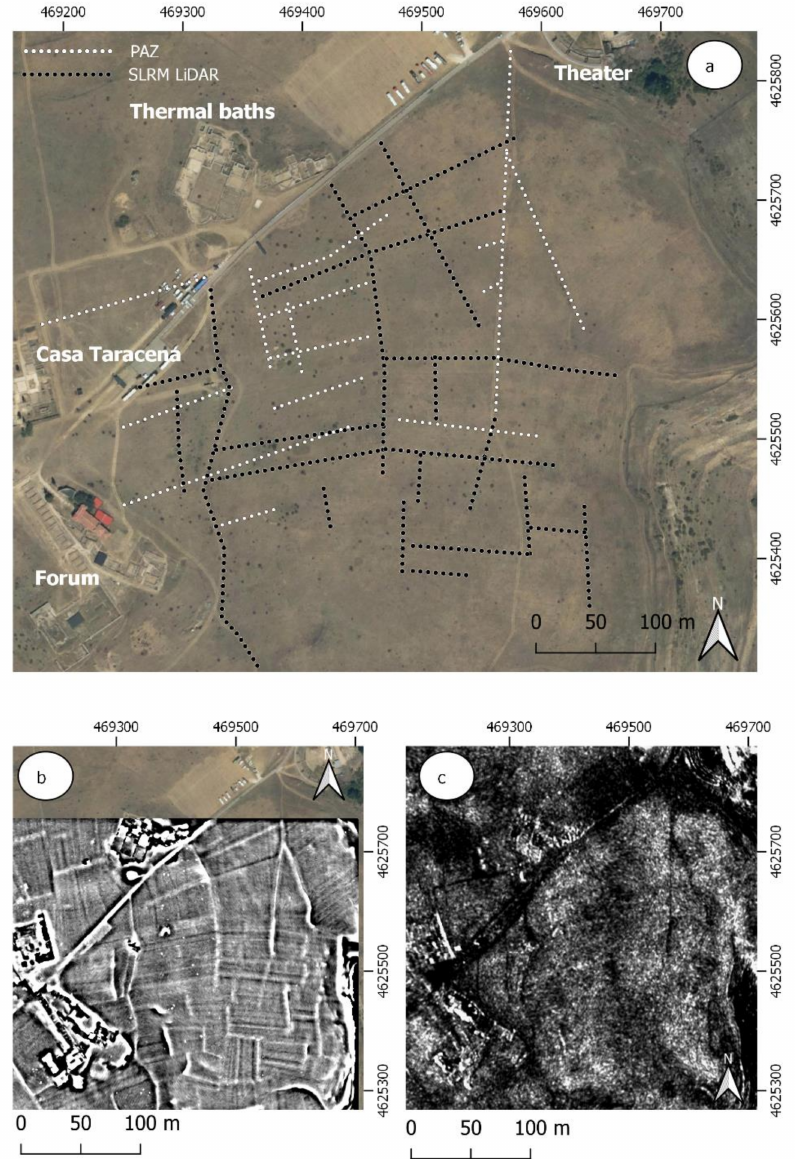
Figure 12. ( a ) Google satellite QuickMapServices; ( b ) Result of the simple local relief model (SLRM) function on the DSM obtained from LiDAR PNOA; ( c ) Image resulting from the multi-temporal application of the co-register function with five SAR-X images of